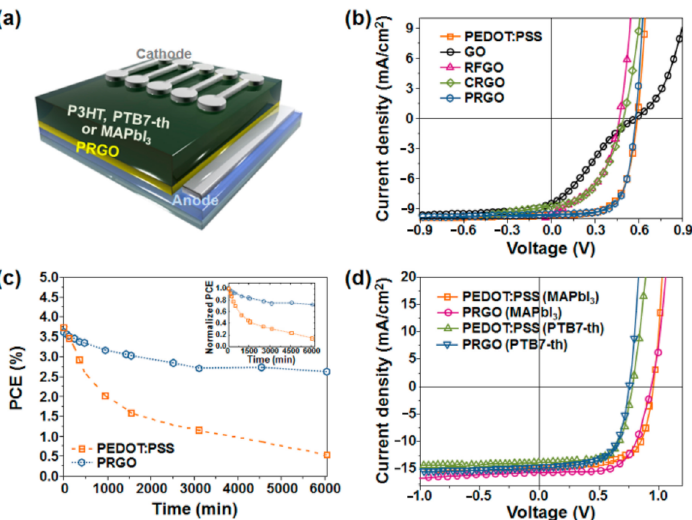
Figure 13. ( a ) Schematic configuration of P3HT-, PTB7-Th-, and MAPbI3-perovskite-based PVs with PRGO as a HEL; ( b ) representative J-V characteristics of P3HT-based devices with different HELs of PEDOT:PSS, GO, RFGO, and PRGO; ( c ) PCE decay of P3HT-based PVs with different HELs of PEDOT:PSS and PRGO as a function of exposure time to the ambient atmosphere (the inset shows the normalized PCEs); ( d ) representative J-V characteristics of PTB7-Th- and CH3NH3PbI3-perovskite- based PVs with different HELs of PEDOT:PSS and PRGO. Reproduced from [103] with the permission of